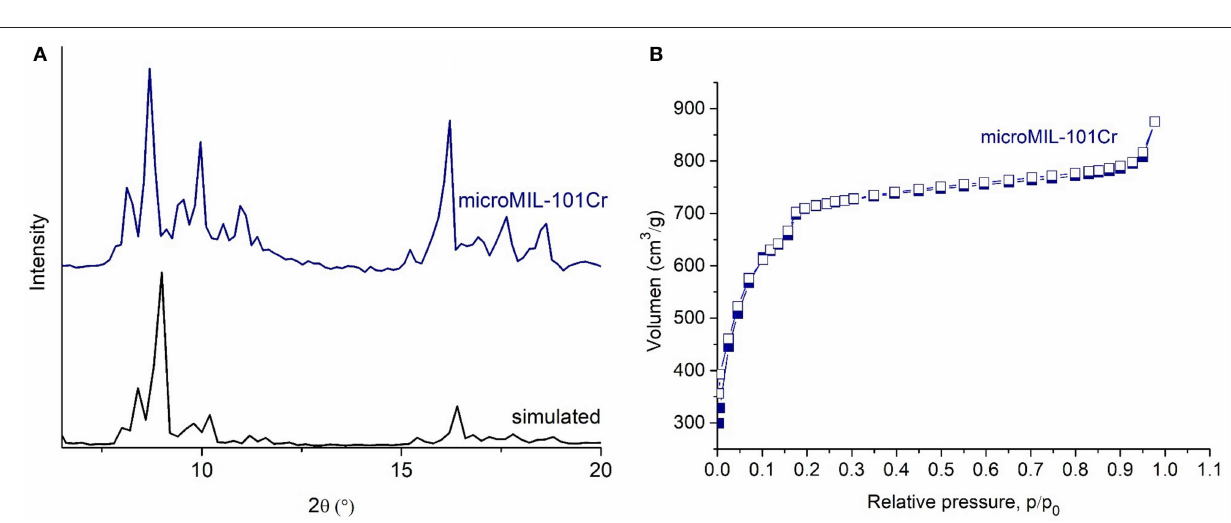
FIGURE 4 | SEM images of the sample prepared in direct emulsion for 40min at 180 ◦ C (A) , 70min at 180 ◦ C (B) and 70min at 210 ◦ C (C,D) .